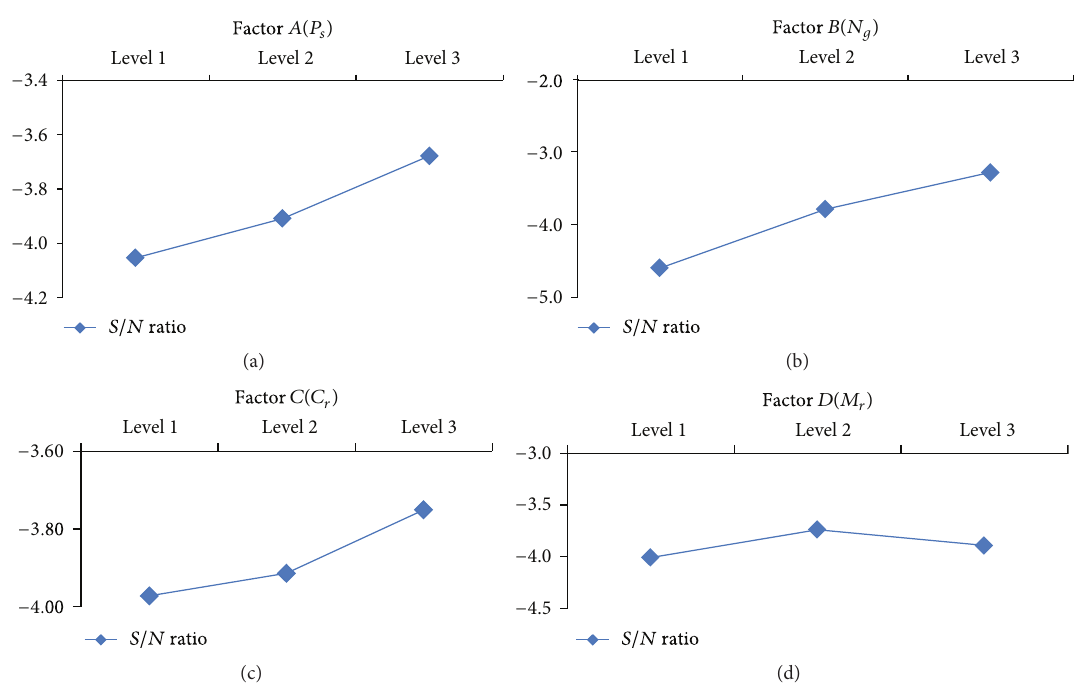
Figure 5: Diagram of mean effect of the 𝑆/𝑁 ratio for small problem in genetic